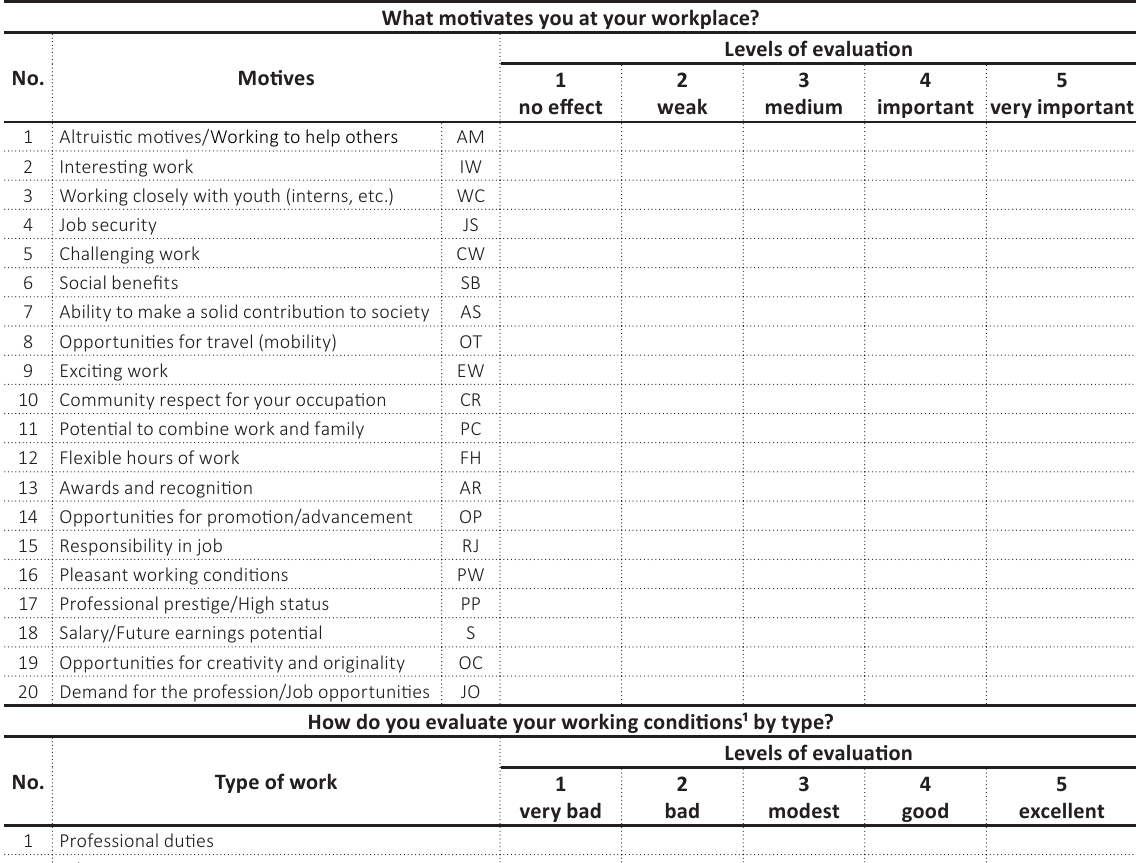
Source: Goncharuk (2018), Goncharuk et al.